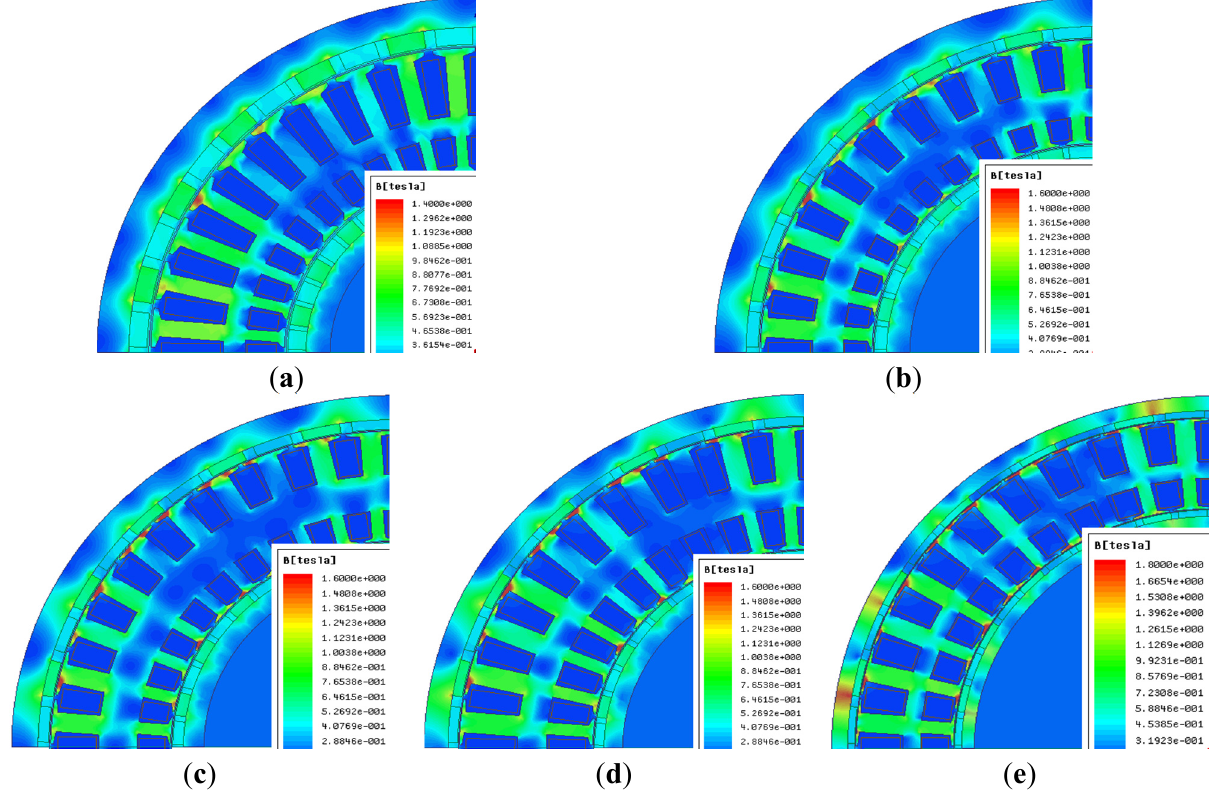
Figure 7. The flux densities distribution of ( a ) 1 kW; ( b ) 5 kW; ( c ) 10 kW; ( d ) 20 kW; and ( e ) 70